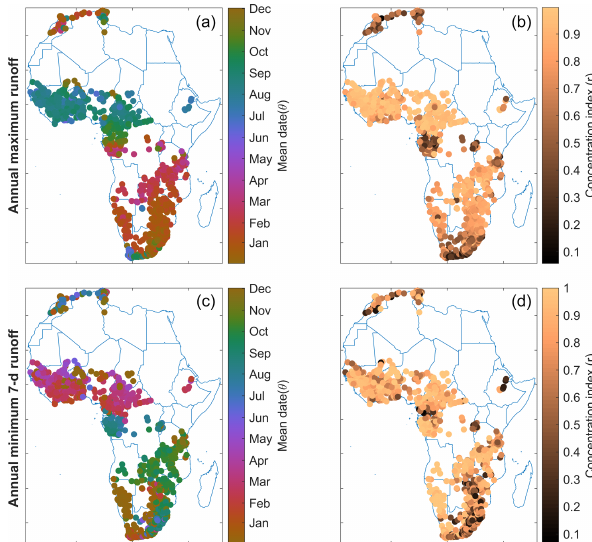
Figure 8. Mean date of occurrence (a, c) of annual maximum runoff and annual minimum of 7d runoff, together with the variability around the mean date (b, d) represented by the concentration